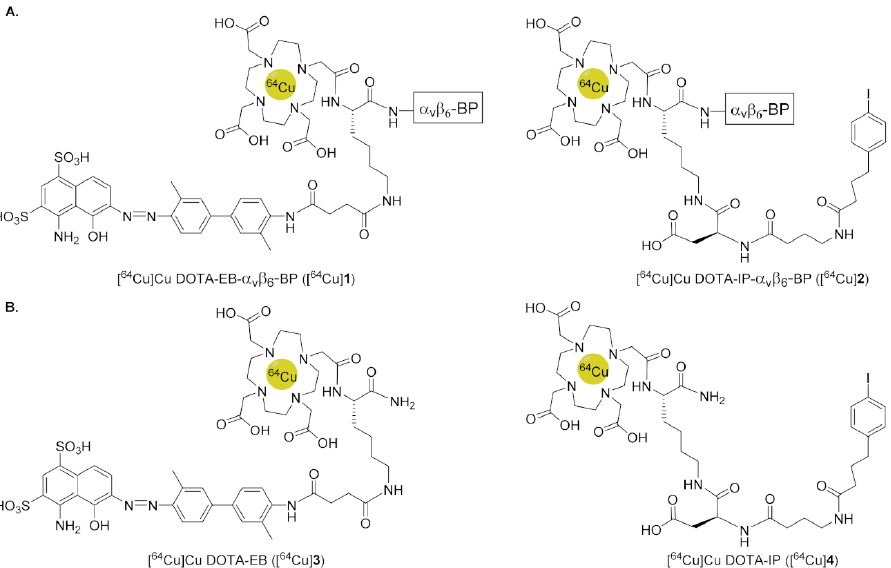
Figure 1. ( A ) Chemical structures of 64 Cu-radiolabeled-ABM- α v β 6 -BP: [ 64 Cu]Cu DOTA-EB- α v β 6 -BP and [ 64 Cu]Cu DOTA-IP- α v β 6 -BP ([ 64 Cu] 1 and [ 64 Cu] 2 ). ( B ) Chemical structures of 64 Cu-radiolabeled non-targeting-ABM controls: [ 64 Cu]Cu DOTA-EB and [ 64 Cu]Cu DOTA-IP ([ 64 Cu] 3 and [ 64 Cu] 4 ). [ α v β 6 -BP = PEG 28 -NAVPNLRGDLQVLAQRVART-PEG 28 -CONH 2